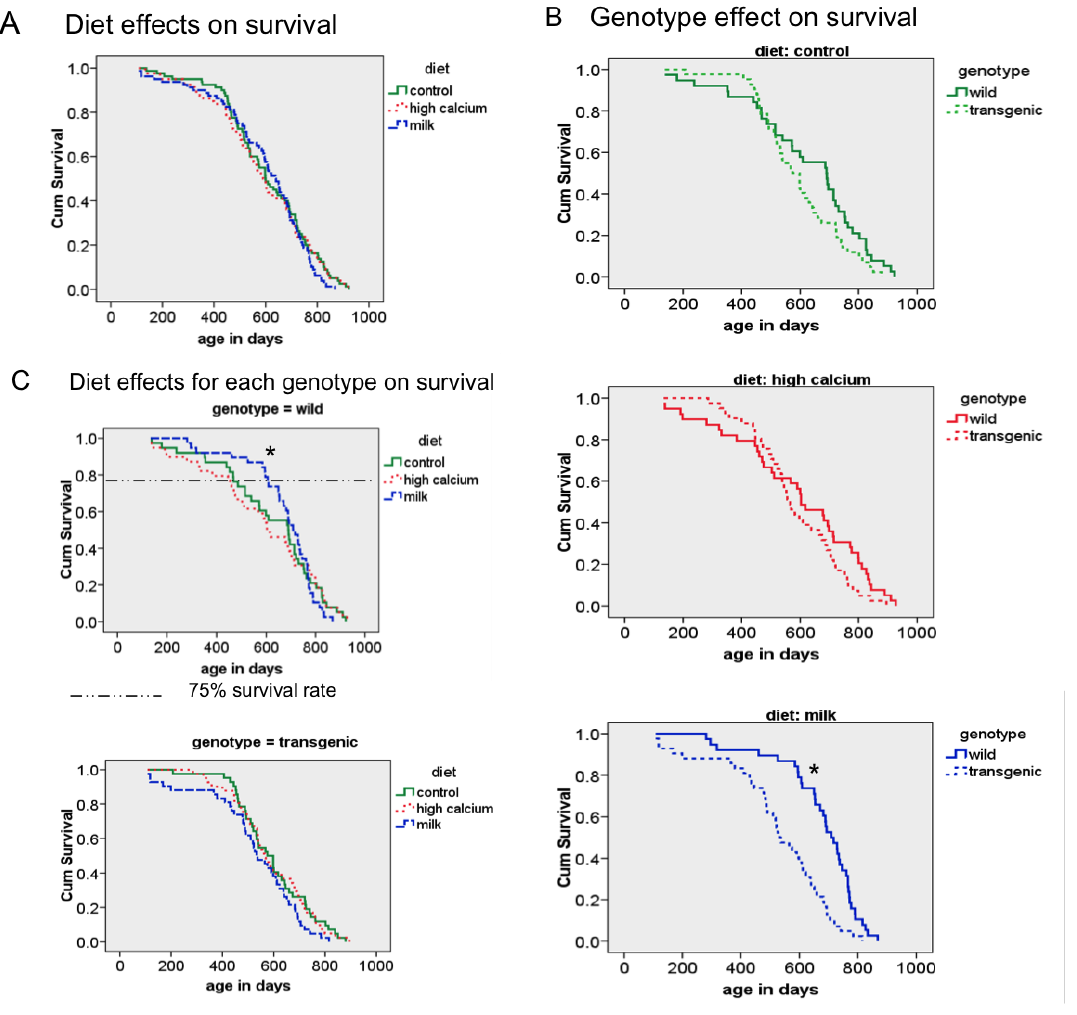
Figure 3. Survival curves of all aP2- agouti transgenic and wild-type mice fed control, high calcium or NFDM diets. A: Diet effect on survival independent of gender and genotype. B: Genotype effect on survival independent of diet. C: Diet effect for each genotype on survival. * Significant different, p <